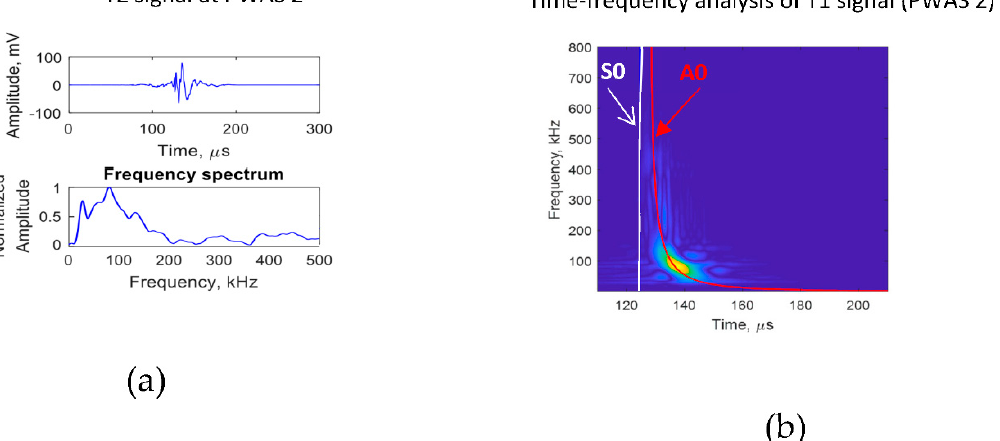
Figure 16. The time–frequency analysis of T2 AE signal at PWAS 2. ( a ) T2 signal at PWAS–2; Figure 16. The time − frequency analysis of T2 AE signal at PWAS 2. ( a ) T2 signal at PWAS − 2; ( c ) ( b ) Choi–Williams transform of T2 signal at PWAS–2. A strong A0 Lamb wave mode content was Choi–Williams transform of T2 signal at PWAS − 2. A strong A0 Lamb wave mode content was observed for the T2 signal at PWAS − 2. observed for the T2 signal at PWAS–2.